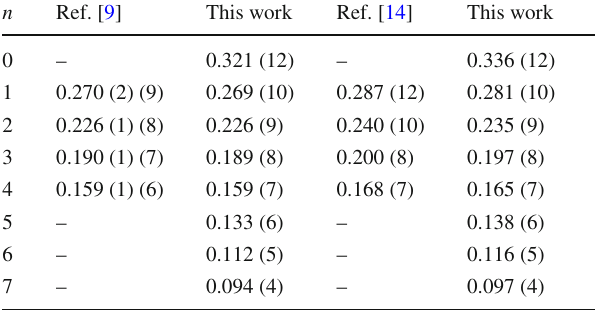
both cases, the ϒ( 4 S ) resonance including its radiative tail is